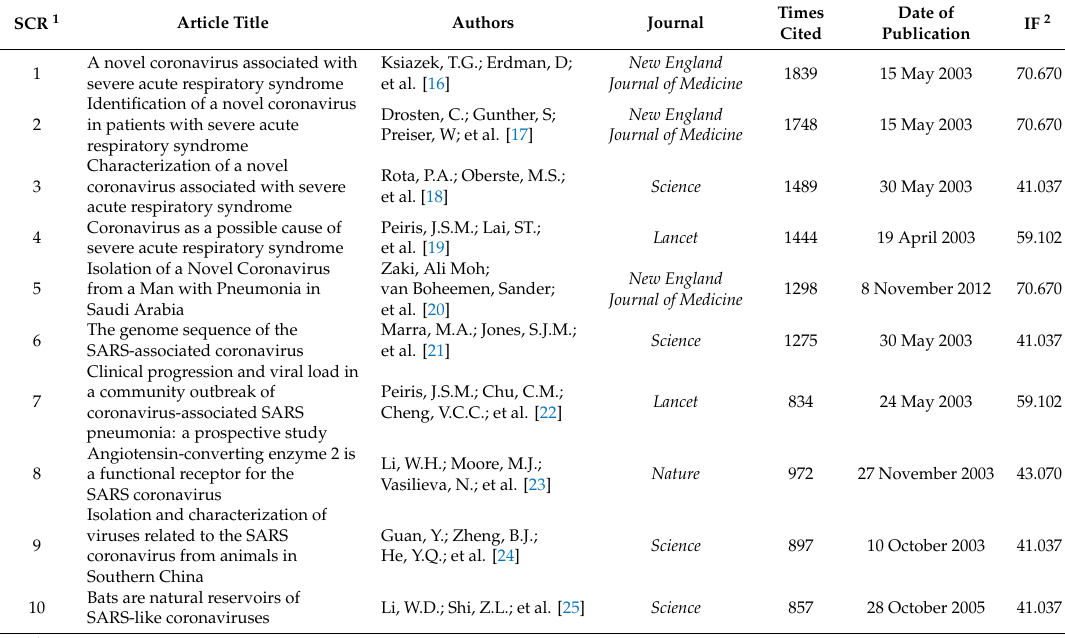
Table 4. The 10 most cited articles on coronavirus